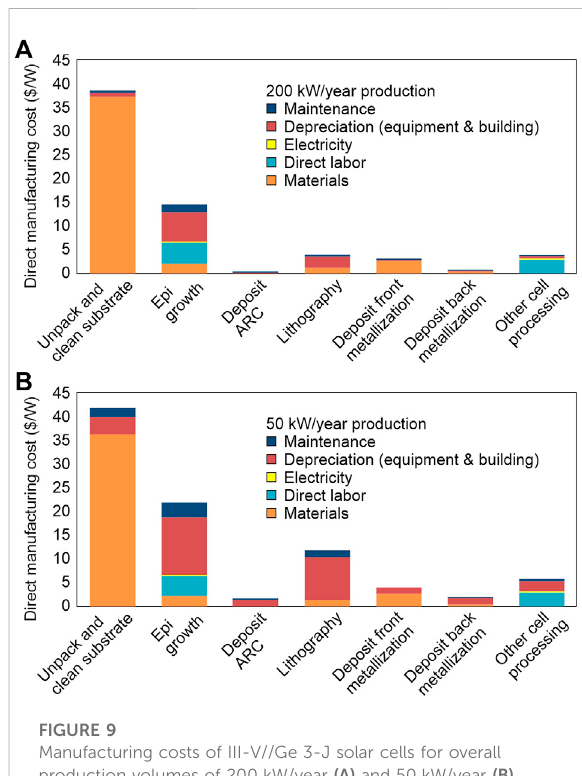
FIGURE 9 Manufacturing costs of III-V//Ge 3-J solar cells for overall production volumes of 200 kW/year (A) and 50 kW/year (B) . Images adapted from (Horowitz et al., 2018).